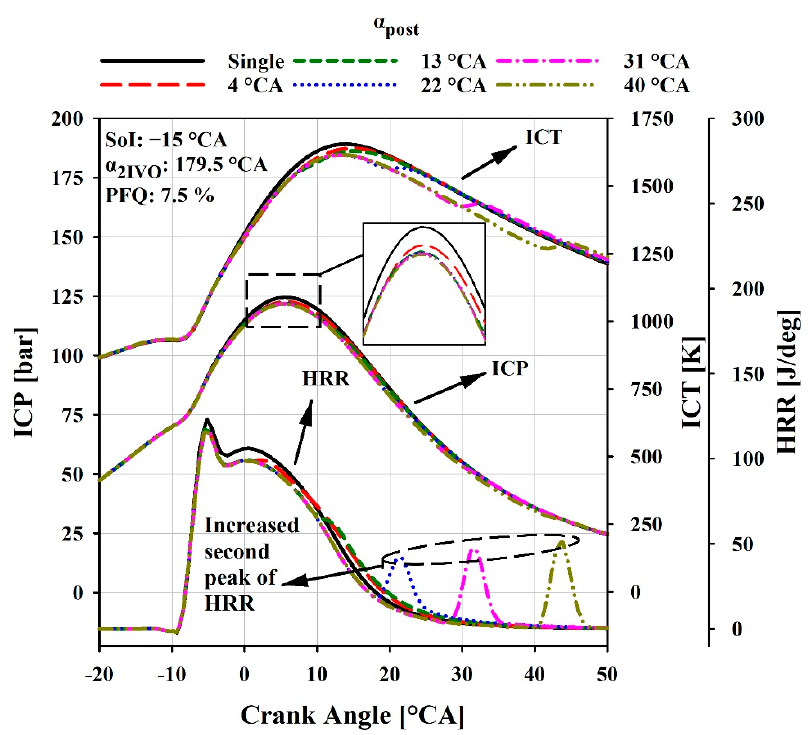
Figure 10. Effect of α post on ICP, ICT and HRR pattern .